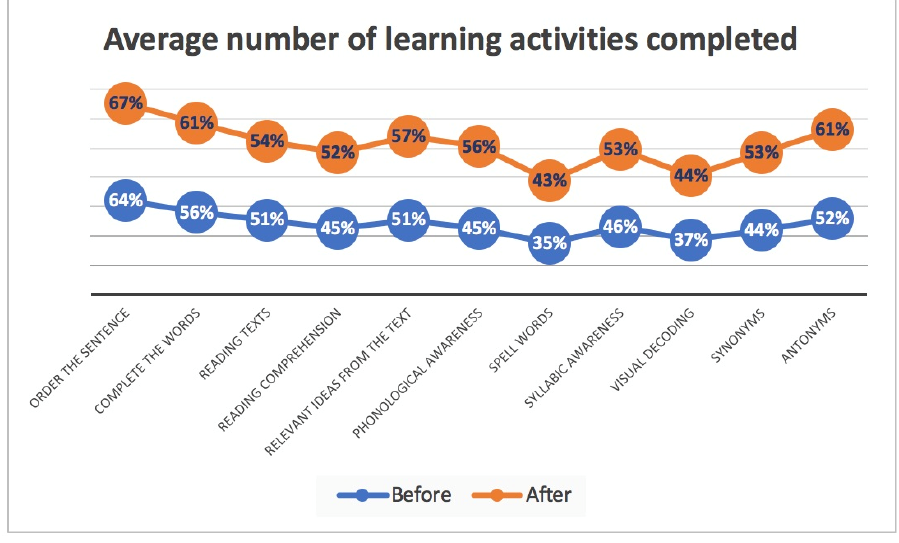
Figure 9. Average of activities solved by the children.